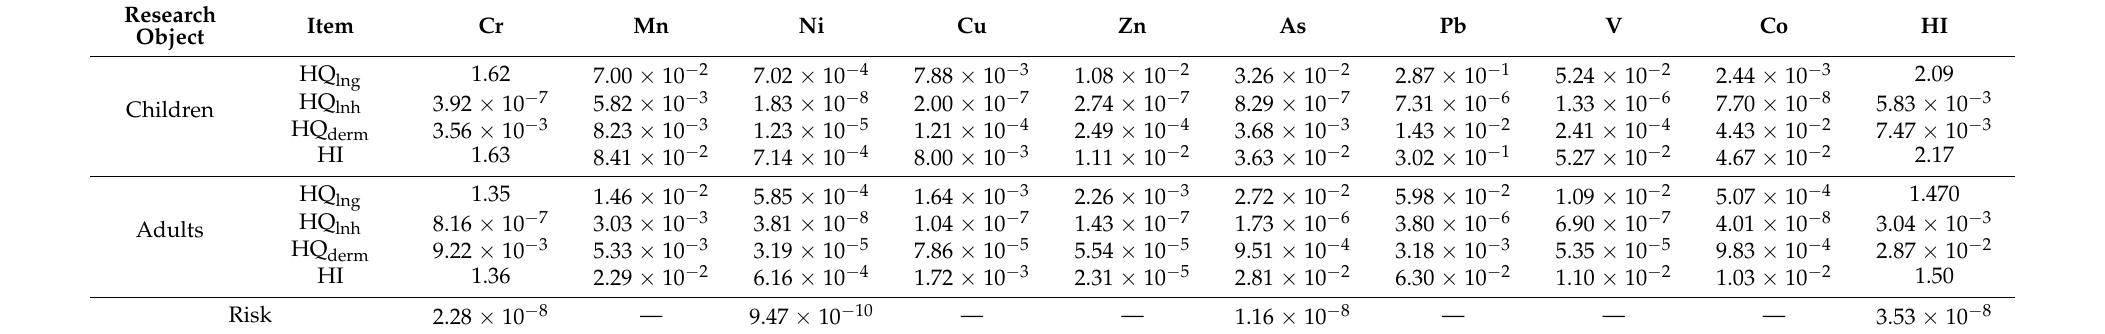
Table 5. Health risks of heavy metals at bus stations in Tianshui